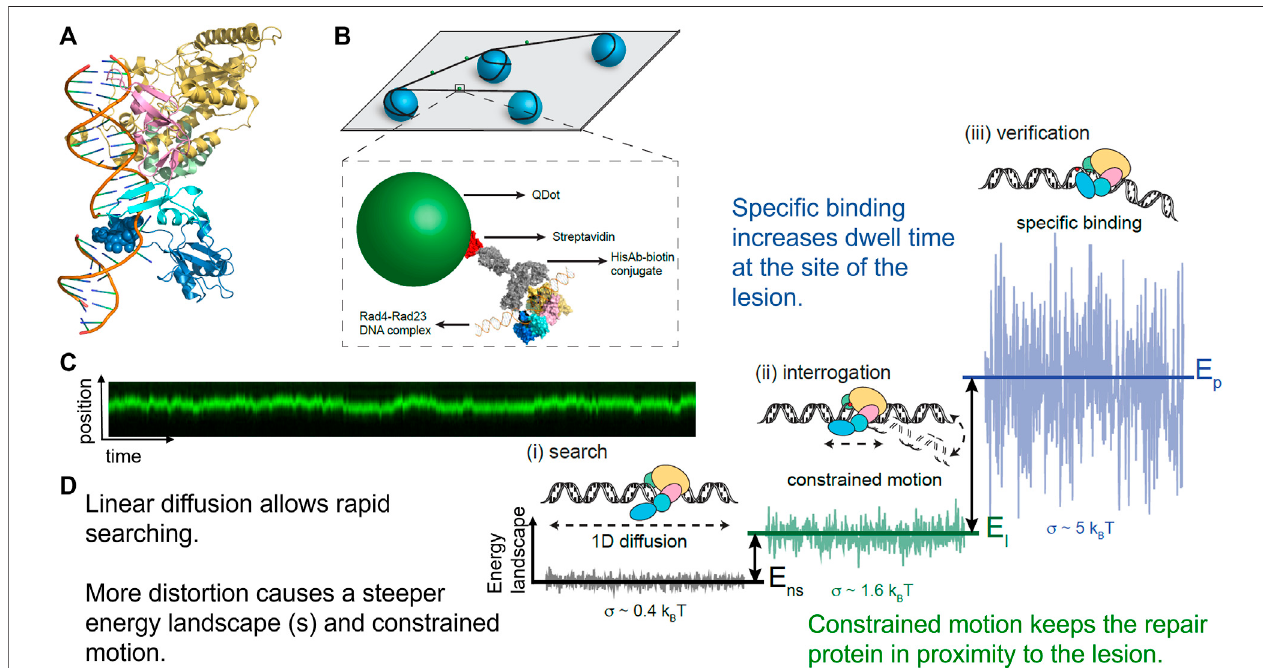
FIGURE 7 | Rad4-Rad23 displays anomalous diffusion on DNA tightropes around UV-induced photoproducts. (A) Co-crystal structure of Rad4-Rad23 bound to DNA containing a CPD-mismatch. PDB ID: 2QSG (Min and Pavletich, 2007). (B) DNA tightrope assay and Qdot-protein conjugation strategy. (C) Example of a kymograph showing binding position on the Y-axis and time on the X-axis of a Rad4-Rad23 particle displaying anomalous diffusion/constrained motion. This particle moved between 500 – 1,000 bp around a cyclobutane pyrimidine dimer. (D) Depiction of how changes in protein-DNA conformation with closing down of beta- harpin 3 in dark blue alter the diffusivity of a particle by creating a steeper energy landscape and in turn lead to reduced linear diffusion, constrained motion, and fi nally a non-motile speci fi c DNA complex. Together these changes in protein-DNA conformation help solve the “ speed-stability ” paradox of allowing rapid diffusion along DNA for lesions, and speci fi c damage detection by DNA repair proteins such as Rad4, XPC, and PARP1. Figure adapted with permission from (Kong et al.,